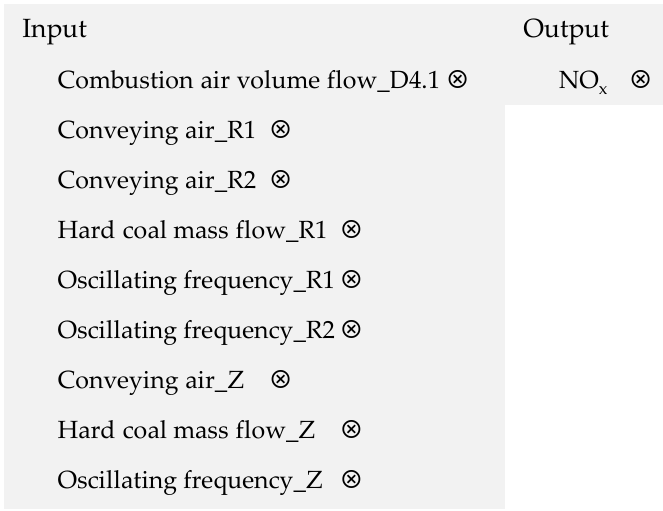
Figure 8. Relevant influencing and target variables of the campaign. Table 1. Experimental program.